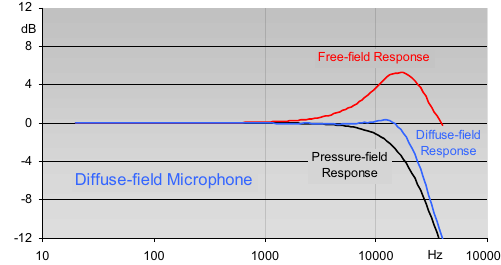
Fig. 1. Working standard microphones. IEC61094-4 types WS1 (23.77 mm), WS2 (12.7 mm) and WS3 (6.35 mm) are shown with and without diaphragm protection grids.